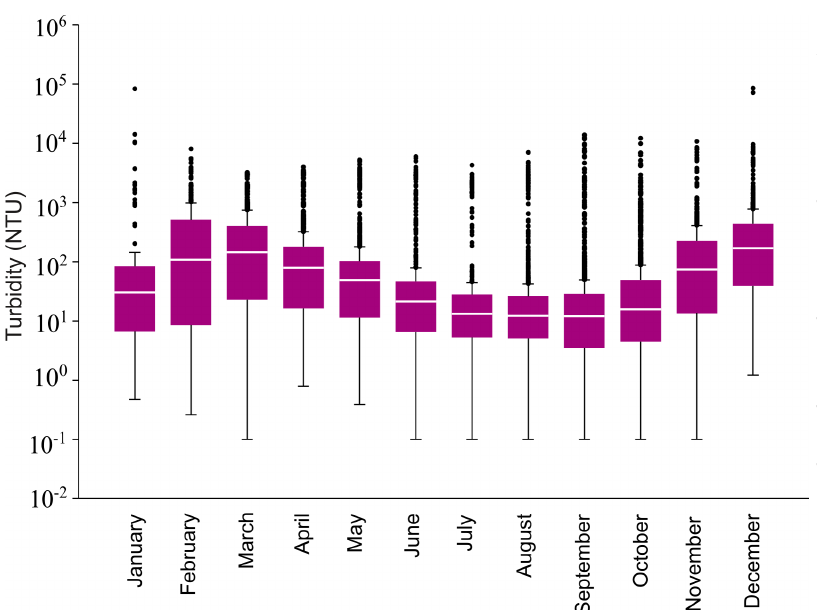
Figure 4. Variations in turbidity values between January and December 2019. The central line inside the box represents the median, and the upper and lower limits of the box represent the first and third quartiles values, respectively. The turbidity follows a seasonal variation, in which the highest values are observed during the rainy season in February and March, steadily decreasing afterward and then increasing at the end of September, strongly matching the variation of river flow shown in Figure